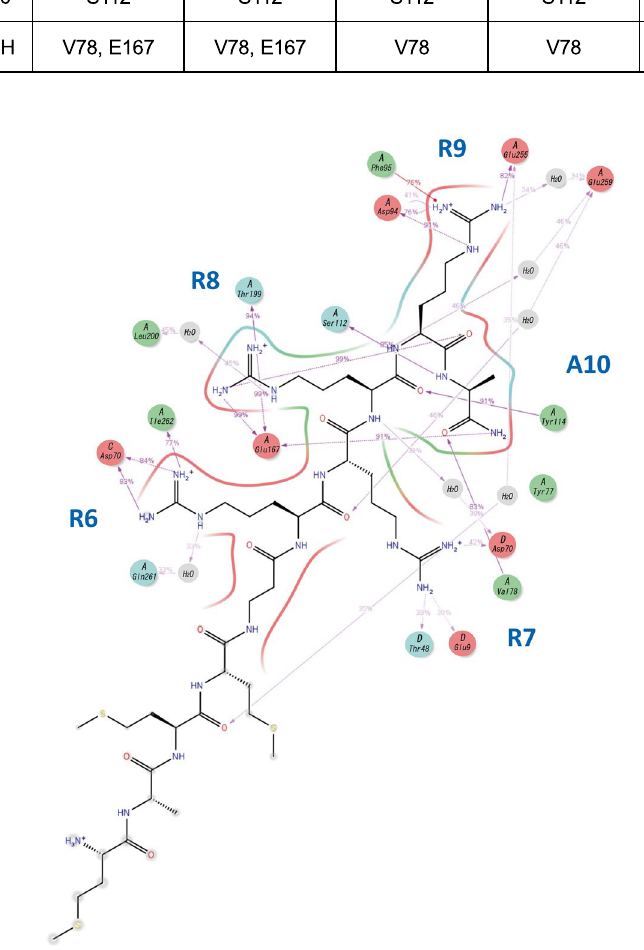
Figure 3. Molecular dynamics (MD) simulations for binding between Stx2a and MMβA-mono. ( a ) Interaction analysis summary from MD simulations of binding between the Stx2a A-subunit and MMβA-mono is shown. Five independent simulation trials (MD1–MD5) were performed. For each MD simulation, Stx2a holotoxin amino acid residues showing more than 80% interaction probability with MMβA-mono are shown. Asterisks indicate residues in the Stx2a B-subunit. ( b ) Scheme showing detailed interactions obtained from MD1. Dotted lines indicate interactions between side chains and the inhibitor, and solid lines indicate interactions between main chains and the inhibitor. Schemes obtained from the other four simulations are shown in Supplementary Fig. S2. The schemes were created using the “Simulation Interactions Diagram” tool in Maestro ver. 2016-2 (https:// www. schro dinger. com/ produ cts/ maest ro). ( c ) Pharmacophore model for binding to the A-subunit was determined based on the consensus interaction model of Arg8-Arg9-Ala10 of MMβA-mono and is shown in the left panel. Right panel shows results from pharmacophore screening of a small molecule database. Red sphere, hydrogen bond acceptor; light blue sphere, hydrogen bond donor; deep blue sphere, positive charge. The schemes were created using Maestro ver. 2016-